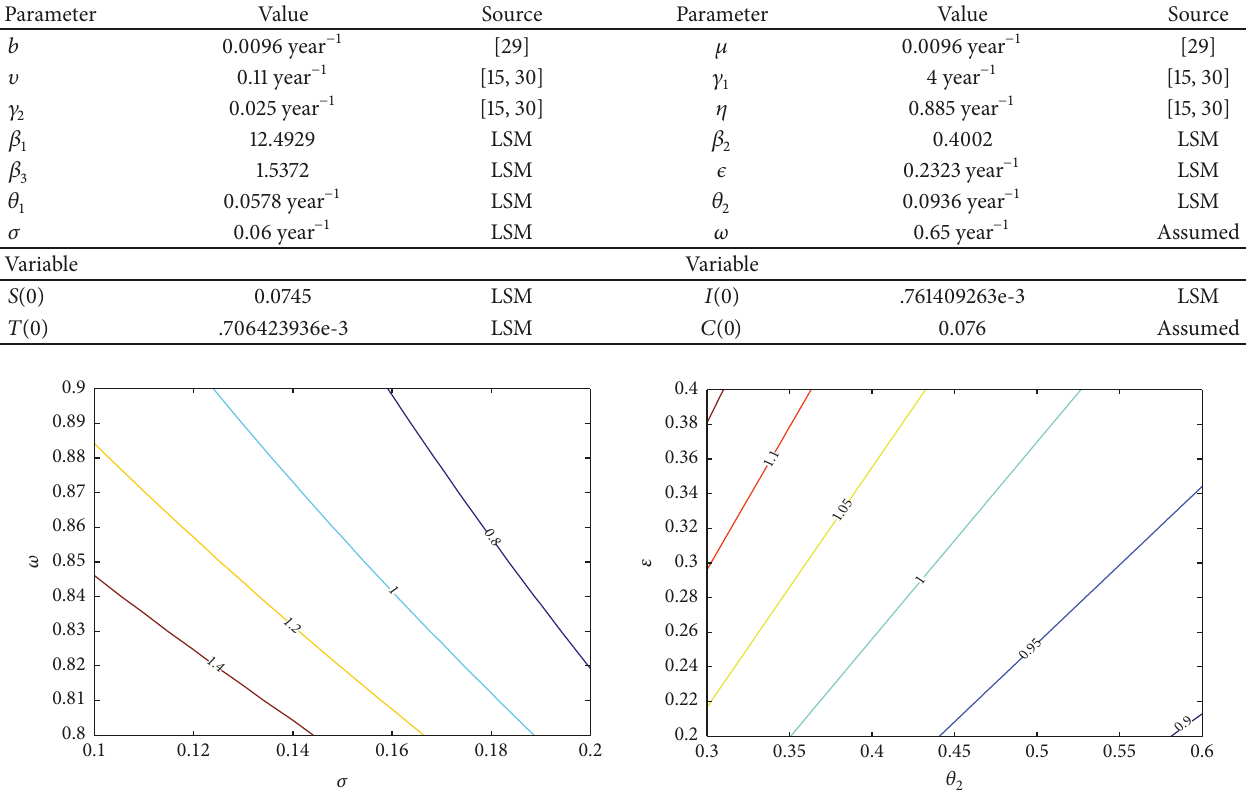
Figure 3: Contour plots of the basic reproductive number R 0 versus the parameter pairs ( 𝜎 , 𝜔 ) (left) and ( 𝜃 2 , 𝜀 ) (right).